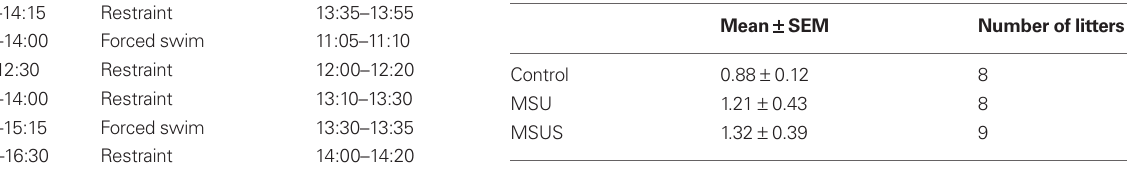
Table 3 | Sex ratio (male/female) within litters of F 1